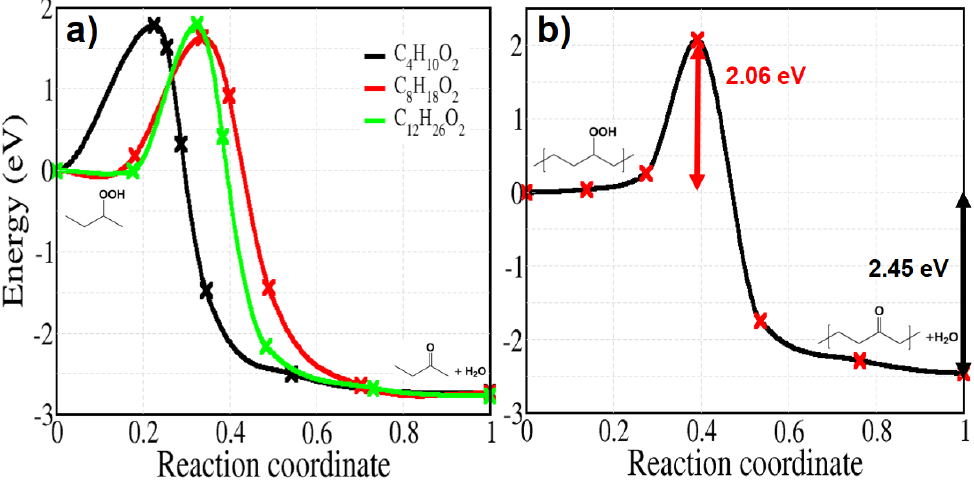
Figure 14. Energy profiles calculated for reaction 9c of Figure 2. Panel ( a ): molecular models of varying sizes. Panel ( b ): crystalline